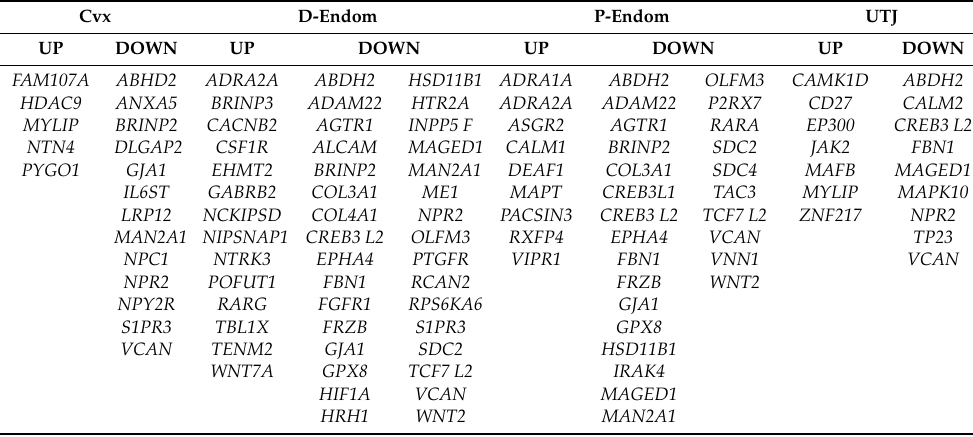
Figure 4. Schematic representation of biologic terms and pathways of selected DEGs, among different mucosal segments of the sow endocervix (Cvx; ( A )), endometrium (distal: D-Endom ( B ) or proximal: P-Endom ( C )) and the utero-tubal junction (UTJ; ( D ) 24 h past copulation. The analysis of overrepresented functional categories was performed using the Cytoscape v3.0.0 application ClueGo v2.0.3. Terms are functionally grouped based on shared genes (kappa score) and are shown in different colors (green: up-regulated; red: down-regulated). The size of the nodes indicates the degree of significance, where the biggest nodes correspond to highest significance and the intensity of the nodes indicates the amount of genes involved in that specific term, where the more intense correspond to the highest number of genes found. The following ClueGo parameters were used: GO tree levels, 1–3 (first level = 0); minimum number of genes, 1; p -value correction, Benjamini–Hochberg, terms with p < 0.05, GO term connection restriction (kappa score), 0.4; GO term grouping, initial group size of 1. The resulting network was modified; that is, some redundant and non-informative terms were deleted and the network manually rearranged. Table 1. Subset of selected di ff erentially expressed genes (DEGs, p < 0.05, up- or downregulated) that copulation in sows induced 24 h later in the endocervix (Cvx), the endometrium (distal: D-Endom or proximal: P-Endom) and the utero-tubal junction (UTJ), classified by relevant biologic terms and pathways according to DAVID